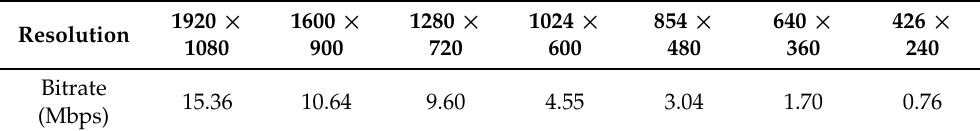
Table 2. Resolution and bitrate for each version [11].